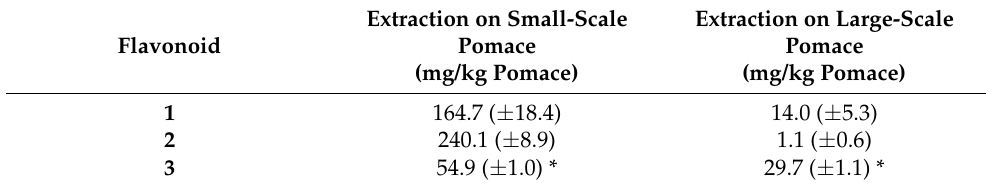
Table 5. Quantities of flavonoids extracted from small-scale (200 g) and large-scale (2 kg) Pinot noir pomace using 40:30:30 (acetone:H 2 O:EtOH) solvent